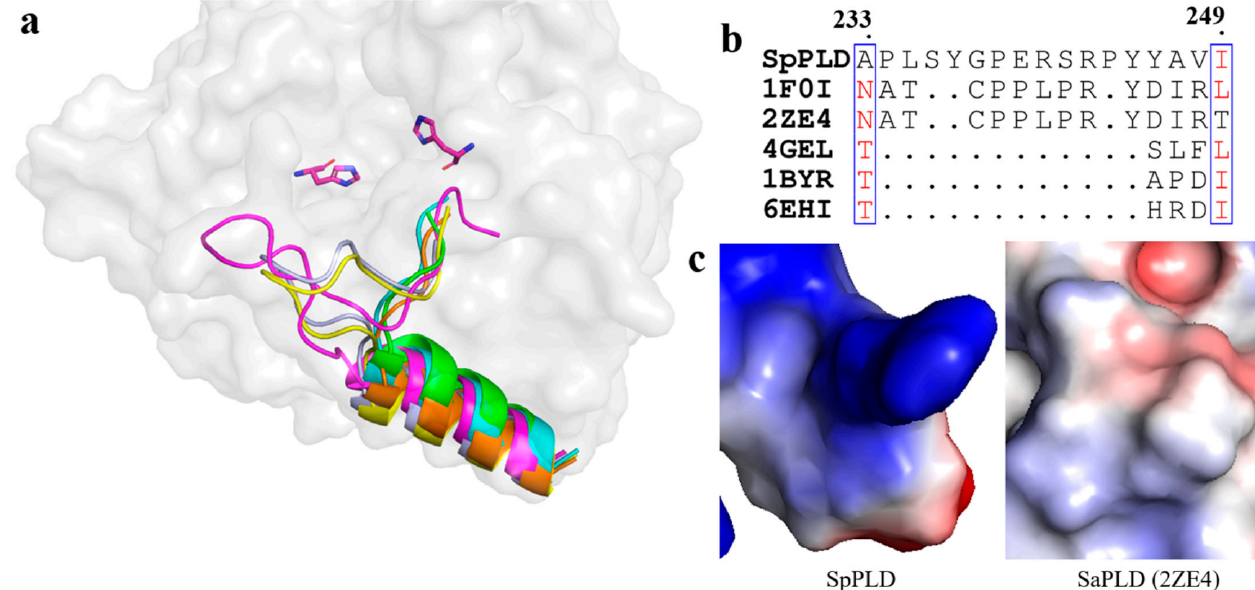
Figure 7. ( a ) Superimpostion and comparision the loop between β 9 and α 9 with other PLDs. SpPLD (magentas, PDB ID: 7E0M), Streptomyces sp. PMF PLD (yellow, PDB ID: 1F0I), SaPLD (light blue, PDB ID: 2ZE4), Zuc (orange, PDB ID: 4GEL), NucT (cyans, PDB ID: 6EHI), Nuc (green, PDB ID: 1BYR). Two catalytic sites of SpPLD were shown in stick. ( b ) Sequence alignment of the amino acids that composed the loop between β 9 and α 9. ( c ) Electrostatic surface potential profile of the loop between β 9 and α 9 in SpPLD and the corresponding loop in SaPLD